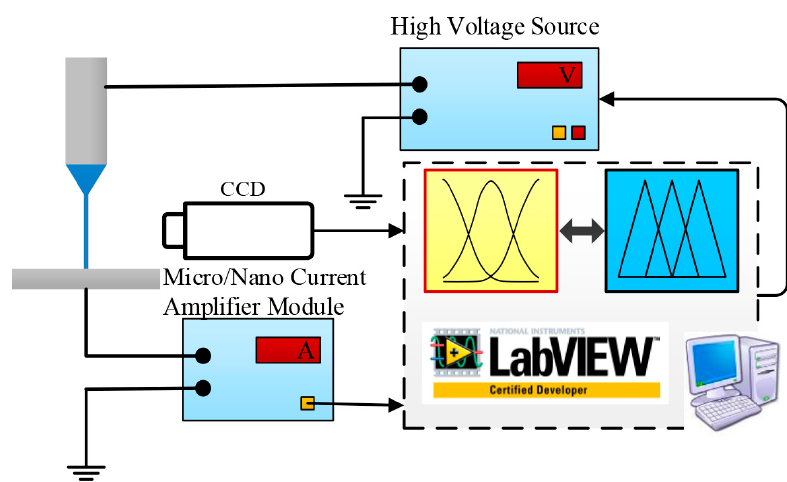
Figure 1. The current detection and measurement system of electrohydrodynamic direct-writing (EDW).